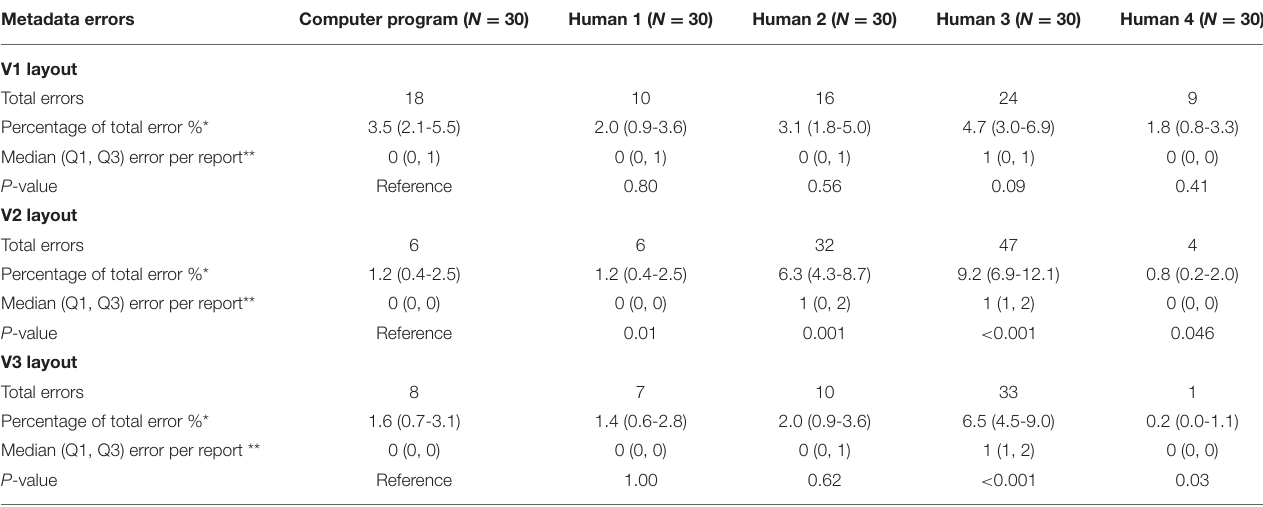
TABLE 3A | Comparison between computer program and human metadata extraction (Metadata